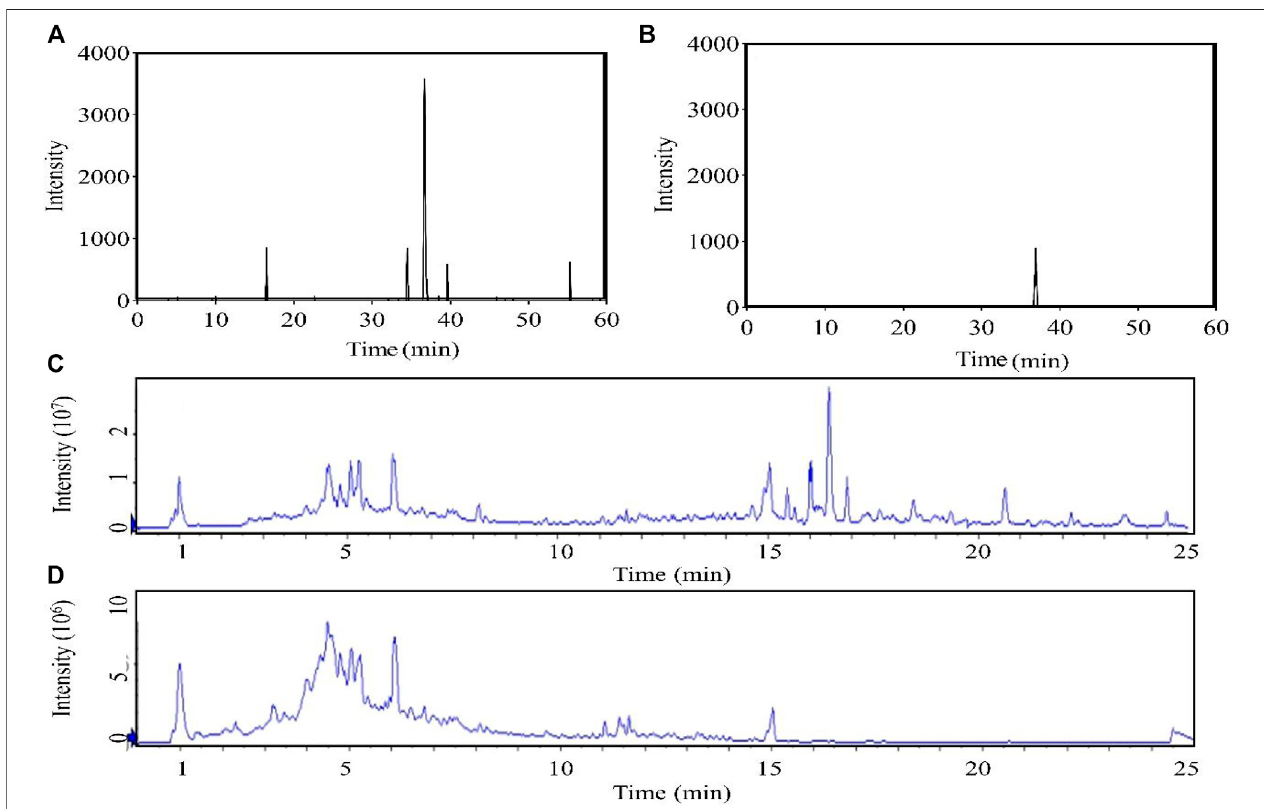
FIGURE 2 | Chromatogram (A) : HPLC chromatogram. (B) : HPLC chromatogram of forsythiaside A standard. The total ion chromatogram obtained in the positive (C) and negative (D)